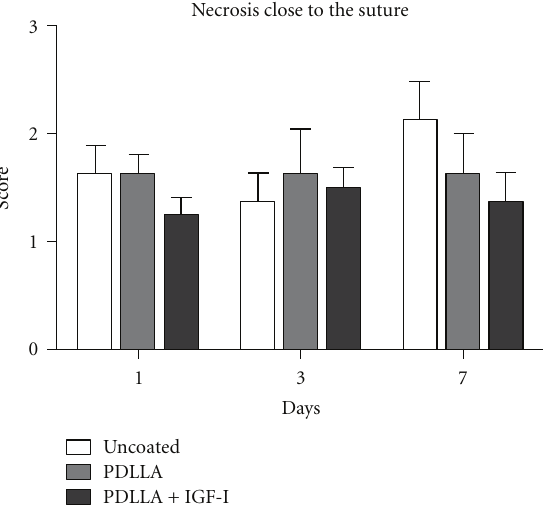
Figure 7: Except in the uncoated group in the region of the anastomosis at day three and day seven, necroses were seen rarely. Especially the coating and the applied IGF-I did not cause any side e ff ects which lead to disturbance of the surrounding tissue at any time